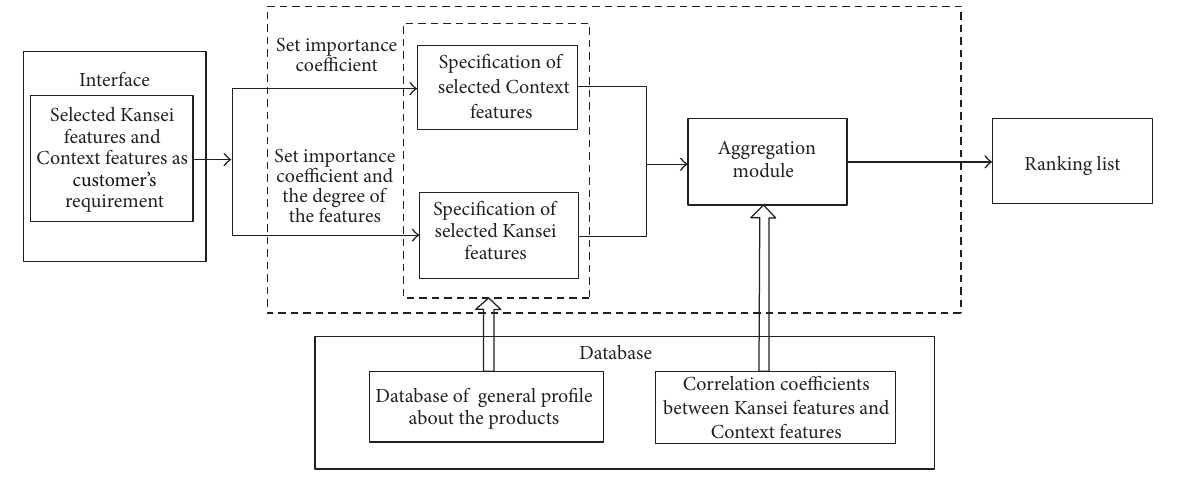
Figure 2: Overview of the recommendation